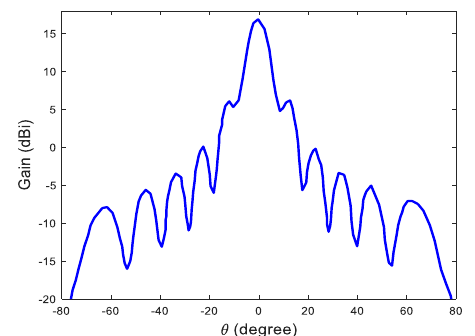
FIGURE 9. 10 𝗑 10 array simulated radiation pattern with no element failure at 𝜙 = 0 & principal plane. T ABLE I. T RAINING P ARAMETERS